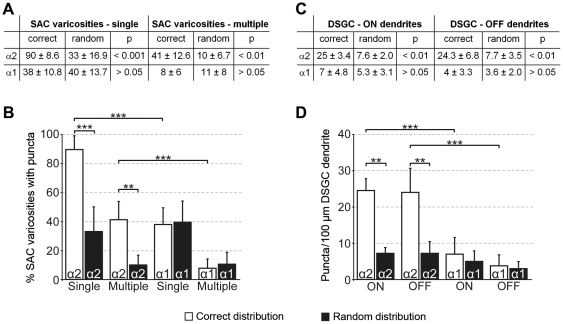
Quantification of candidate GABAA receptor distribution on SACs and DSGCs.
A. GABAAR α2 and α1 puncta distribution in relation to SAC dendrites in percentages of varicosities associated with at least a single punctum (=receptor cluster) and with multiple puncta (α2, n=245 varicosities from 5 cells in 4 retinae; α1, n=181 varicosities from 5 cells in 3 retinae). Percentages and standard deviation values are given for the original data (correct distribution) and for data with one fluorescence channel rotated by 90° (random distribution). B. Percentages of varicosities associated with single or multiple puncta plotted for the correct distribution (open bars) and randomized controls (filled bars). C. GABAAR α2 and α1 puncta distribution in relation to DSGC dendrites in number of receptor clusters per 100 µm of dendritic length for both ON and OFF dendritic arbors (α2, n=3 cells from 3 retinae; α1, n=3 cells from 2 retinae). D. Number of receptor clusters in ON and OFF sublayers plotted for the original data (correct distribution, open bars) and the randomized controls (random distribution, filled bars). Average and standard deviation values plotted in this figure were determined across cells.